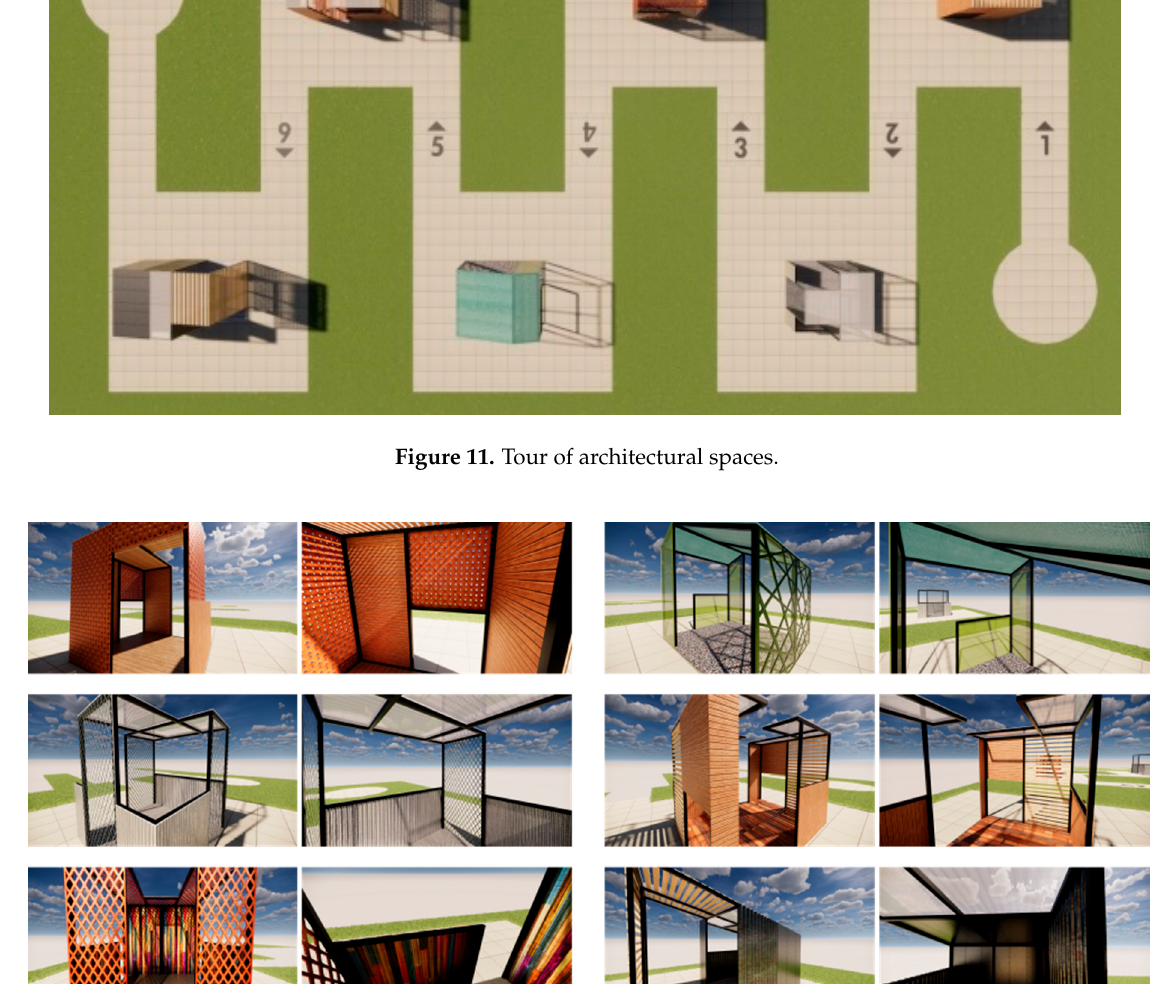
Figure 12. Artificially created architectural spaces in virtual reality environments used for the exercise of identifying sen- sations.